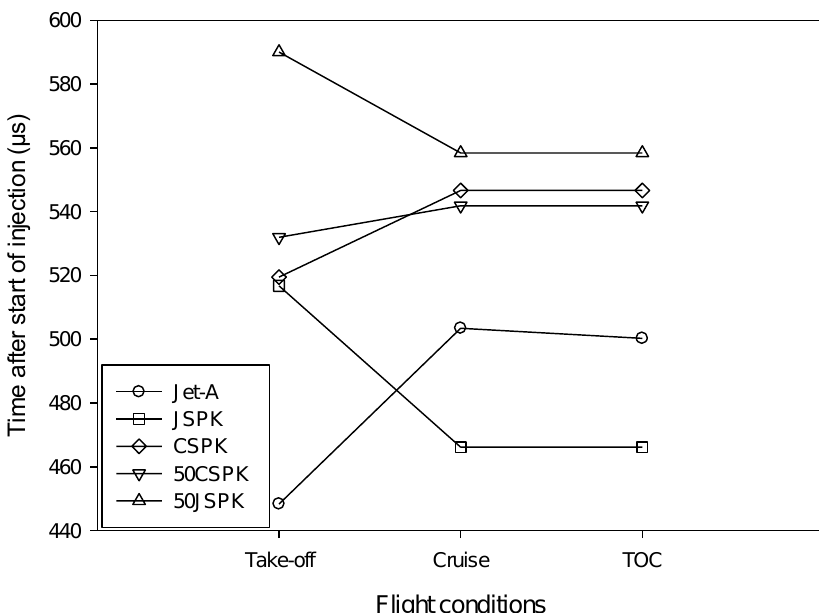
Figure 7. Comparison of the heating-up period of biofuels and Jet–A.